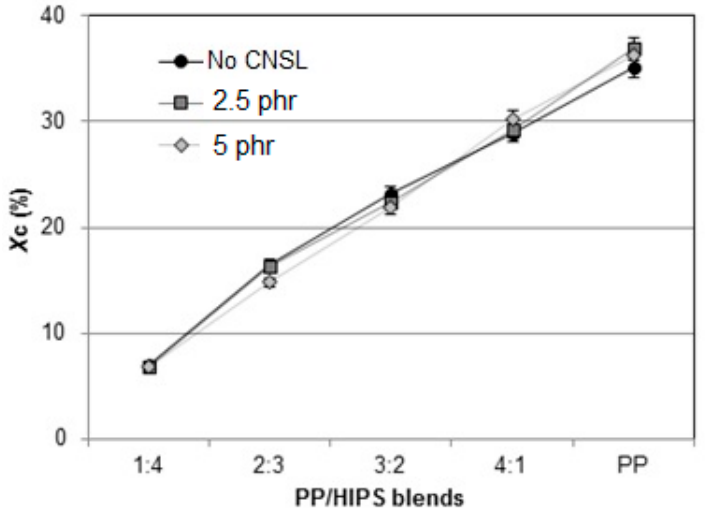
Figure 16. Degree of crystallinity X c of PP and the PP / HIPS blends with 0, 2.5 and 5 phr of CNSL.